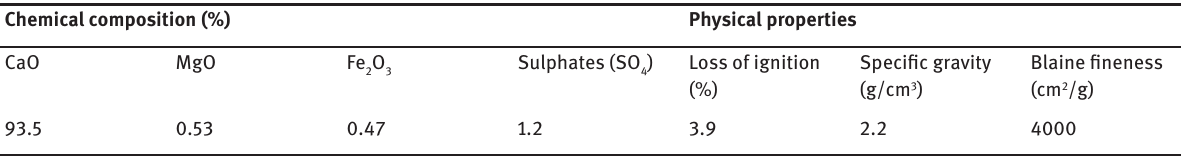
Table 2: Some physical properties with chemical composition of quick lime. Chemical composition